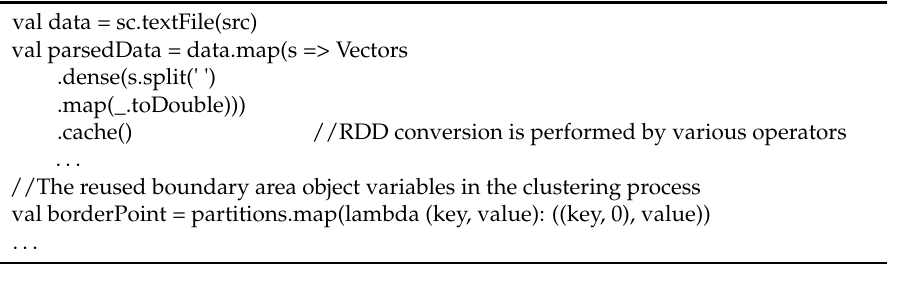
Table 2. Optimization Method One—the pseudo codes before data transmission